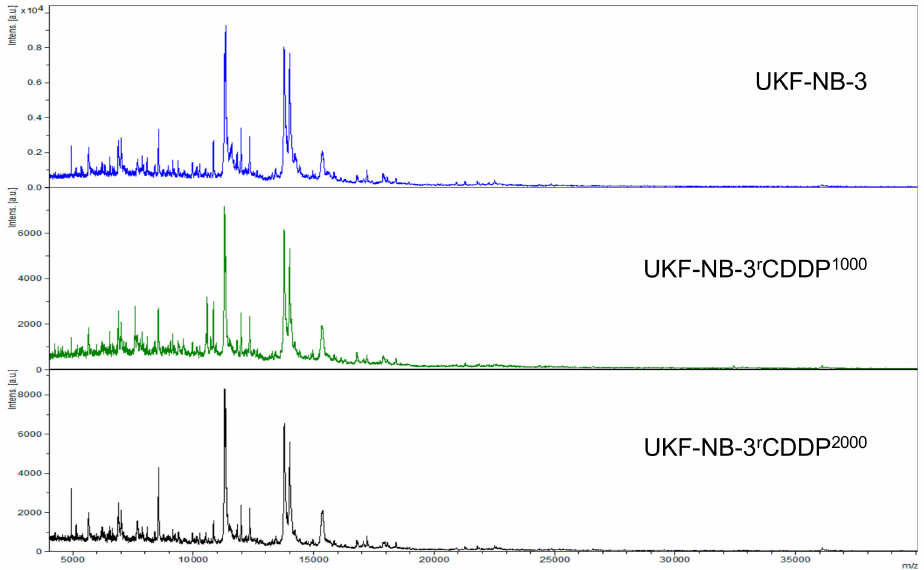
Figure 2. Representative intact-cell MALDI-ToF mass spectrometry analysis spectra of the cell line UKF-NB-3 and its drug-adapted